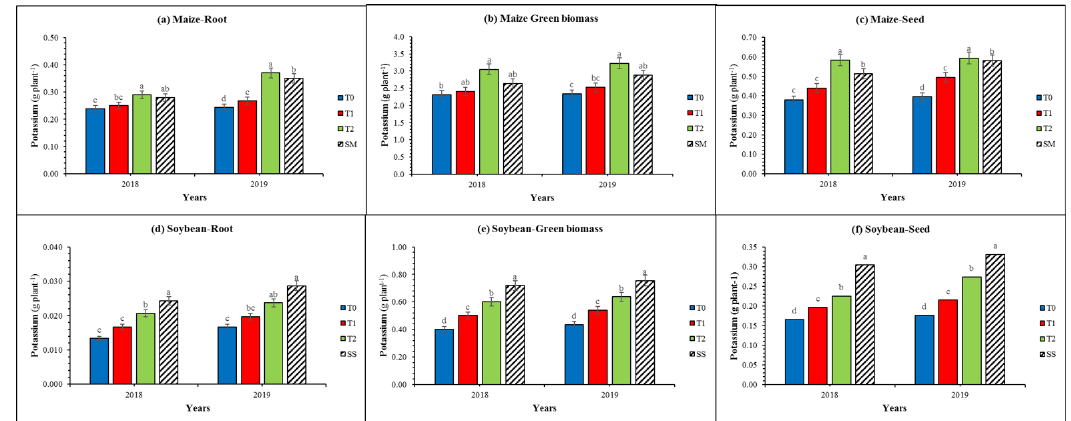
Figure 6. Root, green biomass and grain potassium content of maize ( a – c ) and soybeans ( d – f ) as a ff ected by di ff erent potassium treatments in the maize–soybean intercropping system (MSI) from 2018 to 2019 growing season. The T 0 , T 1 and T 2 represent the no potassium treatment, 40:30 kg ha − 1 and 80:60 kg ha − 1 , respectively, in MSI. The SS and SM refer to sole cropping system of soybeans and maize, respectively. Means are averaged over three replicates ± standard error. Means do not share the same letters in the column di ff er significantly at p ≤ 0.05.